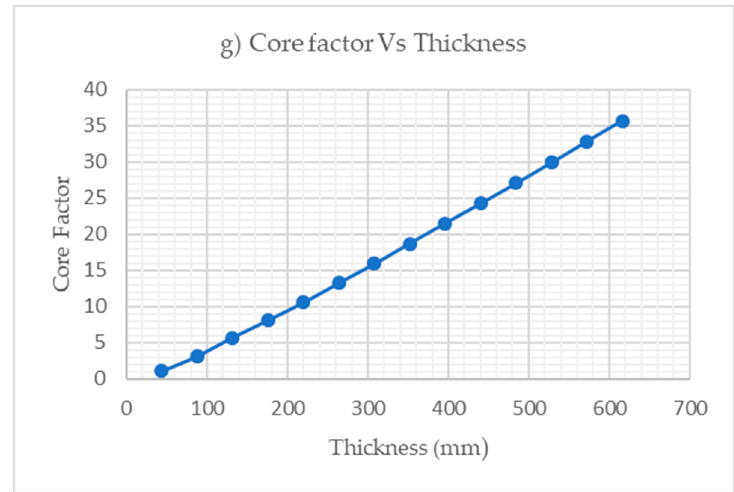
Figure 3. ( a ) Safety factor MS vs. thickness; ( b ) Safety factor Tsai-Hill vs. thickness; ( c ) Max. shear stress vs. thickness; ( d ) Eq. stress vs. thickness; ( e ) Directional deformation vs. thickness. ( f ) Safety factor Tsai-Wu vs. thickness ( g ) Core factor vs. thickness.